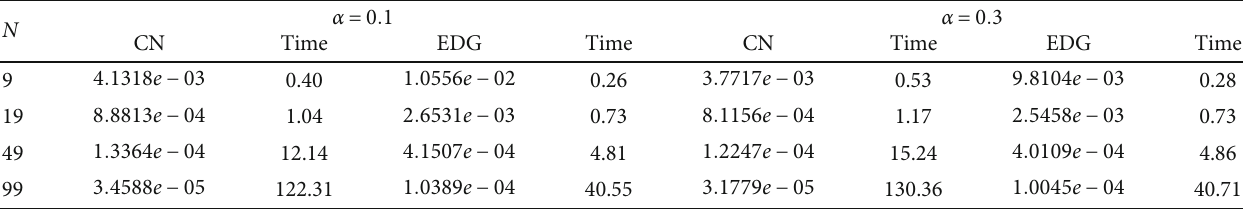
Table 3: Absolute errors of Example 14 at T = 1 for Re = 100 , Δ t = 0 : 01 , α = 0 : 1 , and α = 0 : 3 .